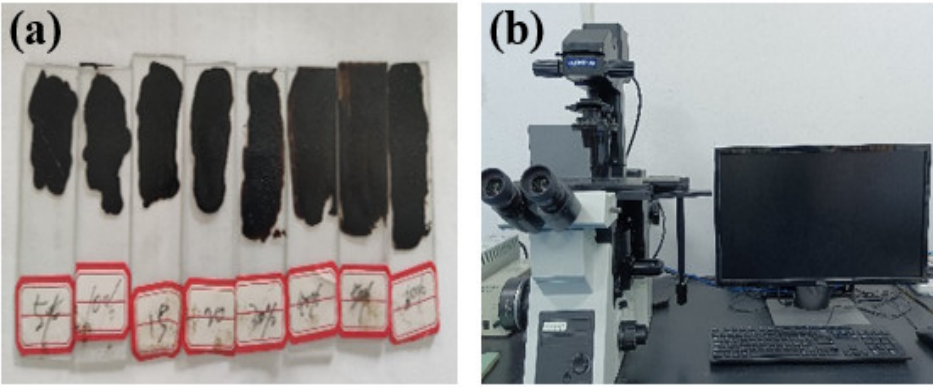
Figure 2. Fluorescent microscope test: ( a ) testing sample; ( b ) test instrument.